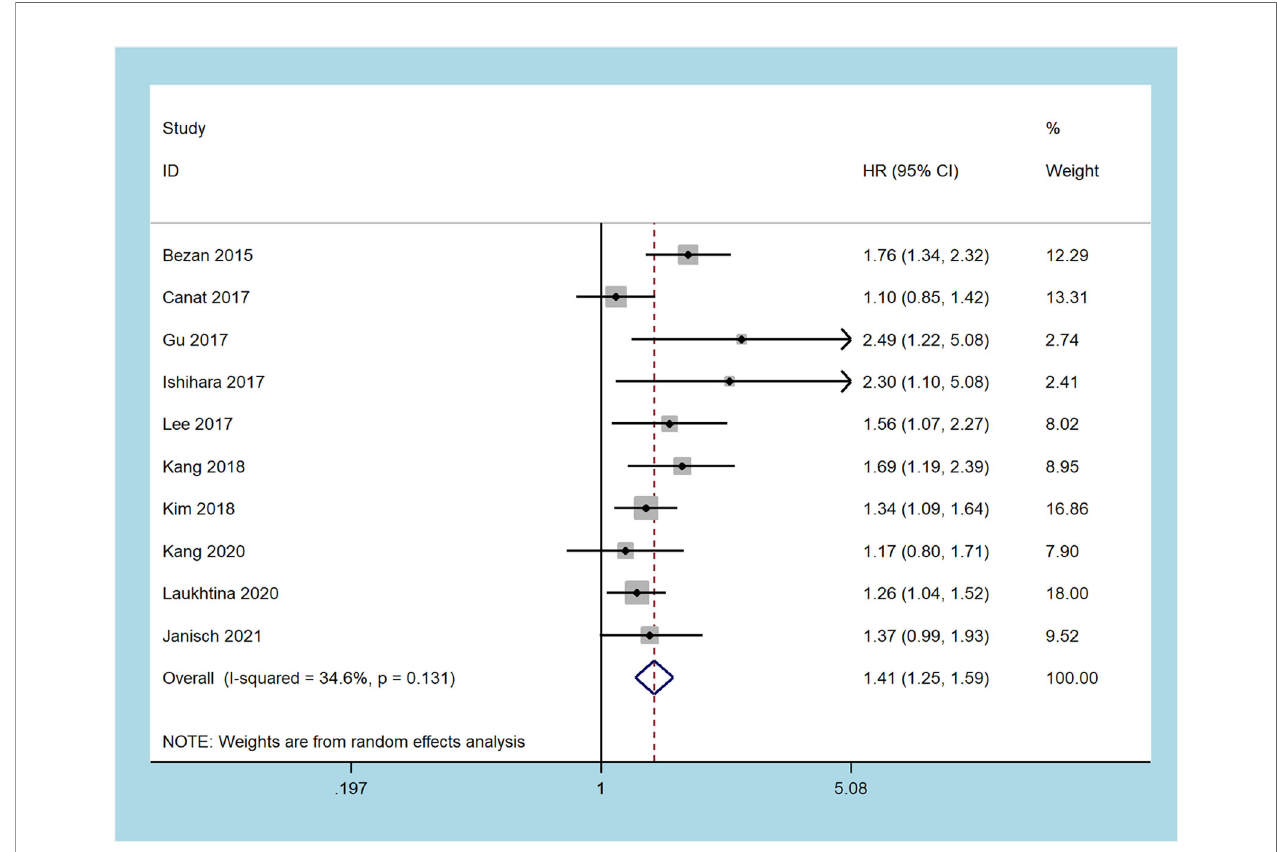
FIGURE 2 | Forest plots of the association between the De Ritis ratio and overall